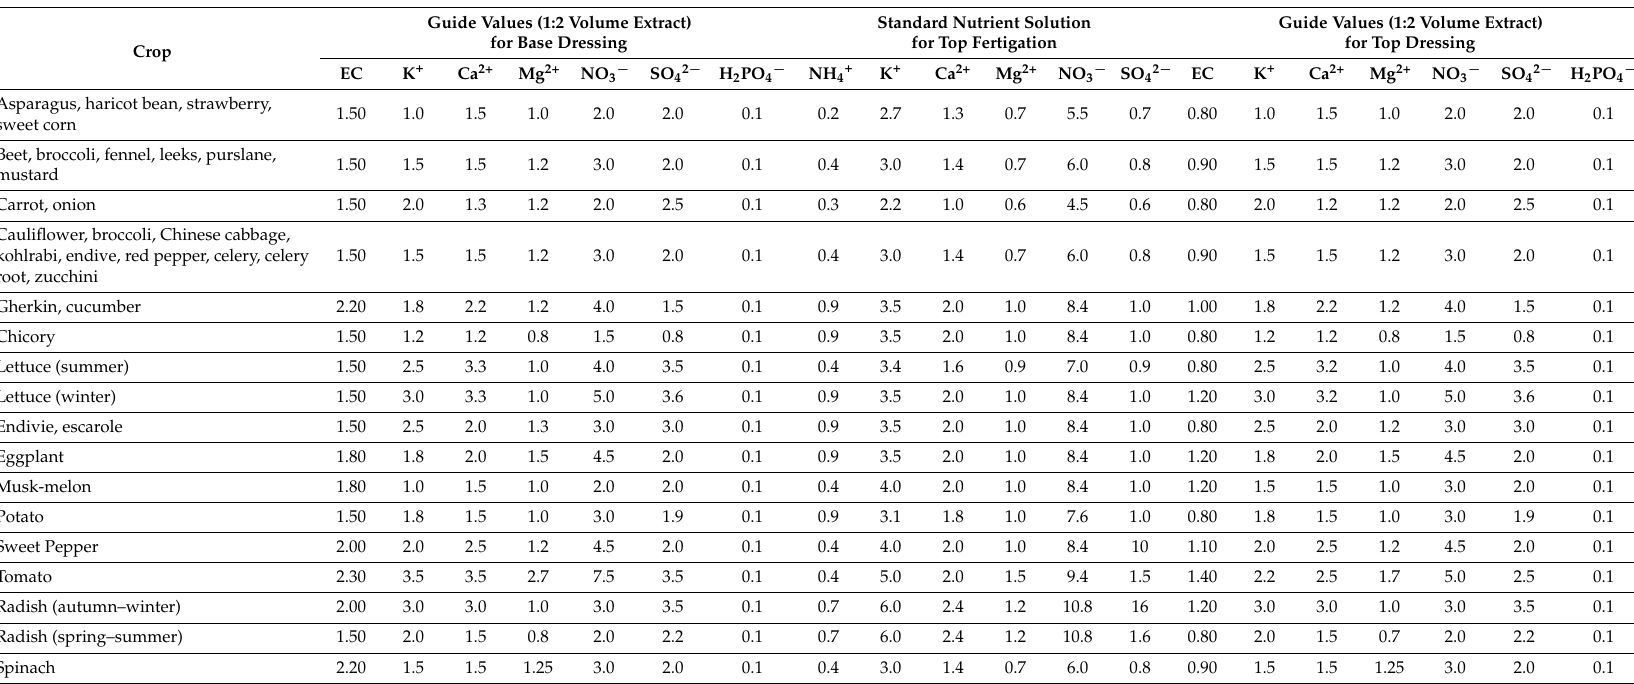
Table 5. Some examples of guideline nutrient concentrations (mmol L − 1 ) and maximum electro-conductivity values (EC, dS m − 1 ) of aqueous soil extracts (1 volume of wet soil: 2 volumes of water) for the base and dressing fertilization of some protected horticultural crops. The standard nutrient solutions advised for protected soil-grown vegetables cultivated in Dutch climate conditions are also